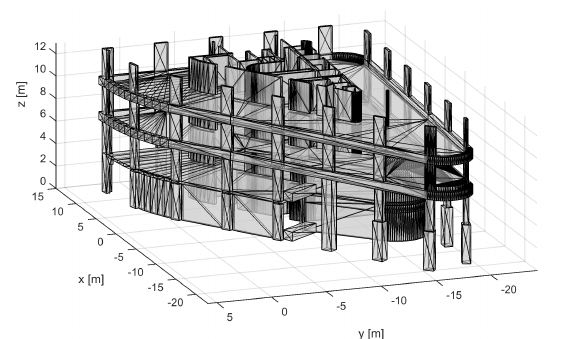
Figure 6. Point cloud for time step 2 on 27 June.